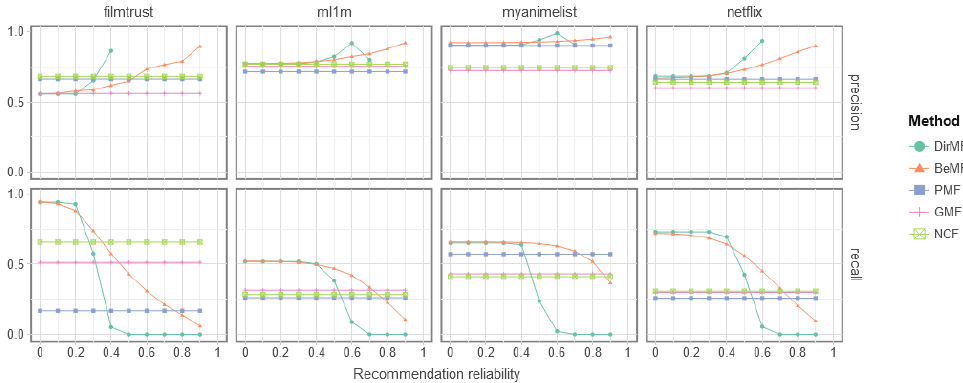
Figure 3. Quality of the recommendations measured by precision and recall. Predictions with lower reliability than those indicated on the x -axis are filtered